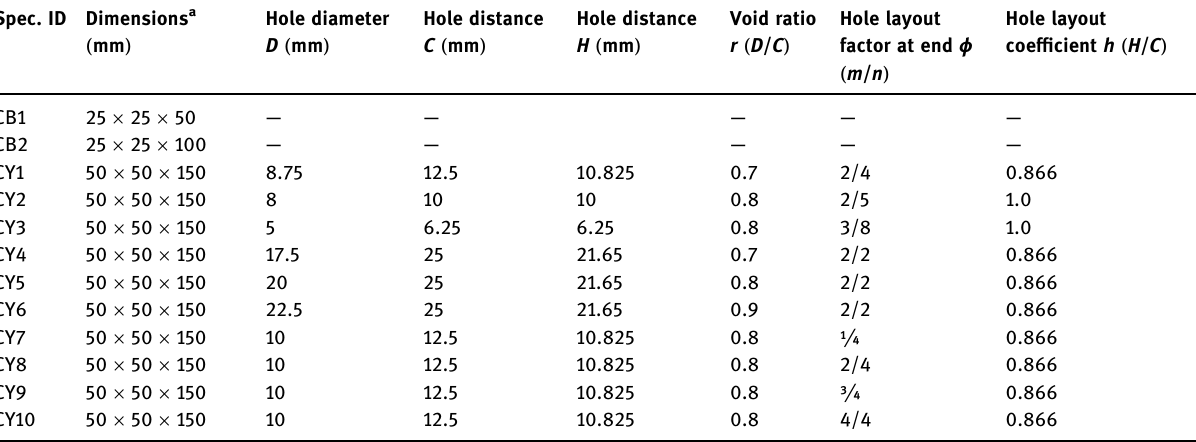
Spec. ID Dimensions